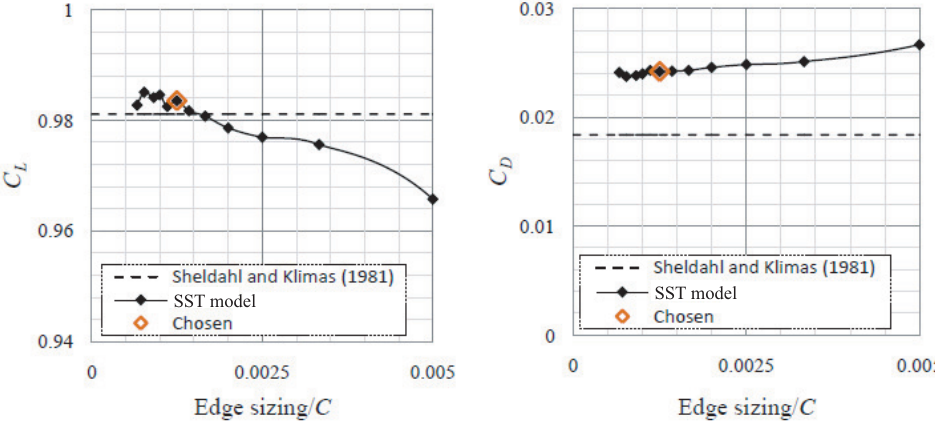
Figure 10. Variation in lift and drag as a function of airfoil edge sizing in the flow-wise direction ( α = 10 ◦ , Re = 3.6 × 10 5 ).